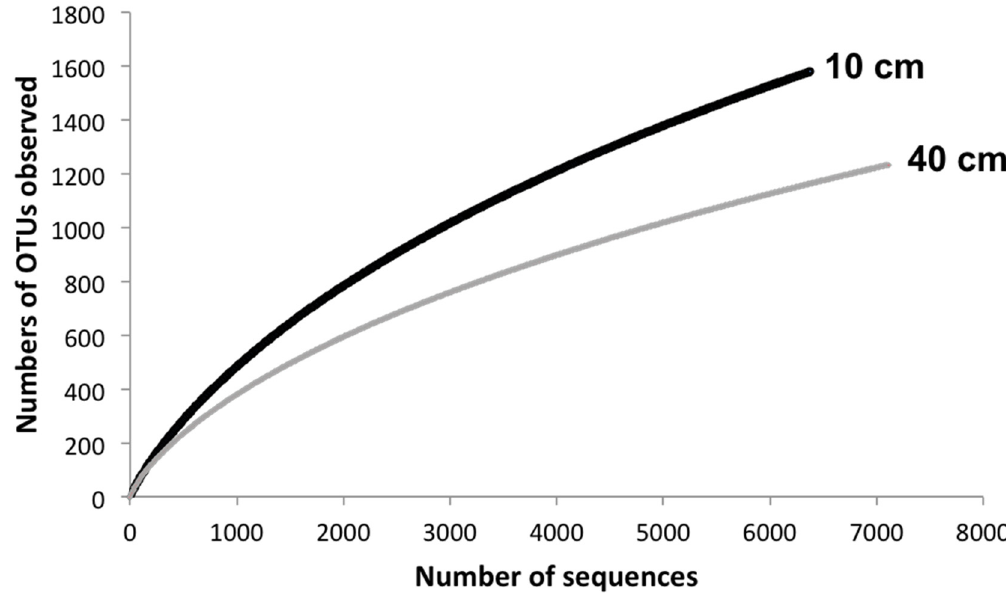
Figure 3. Rarefaction curves generated for 16S rRNA pyrosequence from samples collected at 10 and 40 cm depth in mangrove sediment. Sequences were grouped into OTUs based on a distance sequence similarity of 97%.